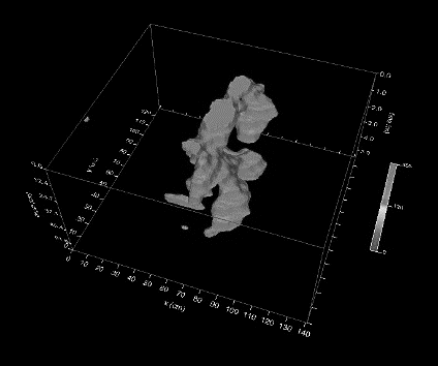
Figure 7. Illustration of isosurfaces in which no root features could be identified.